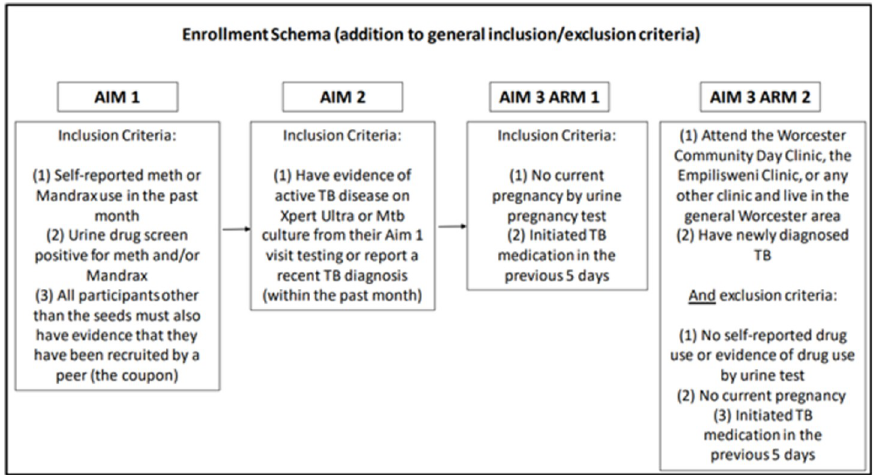
Fig 2. TOTAL participant inclusion criteria per study